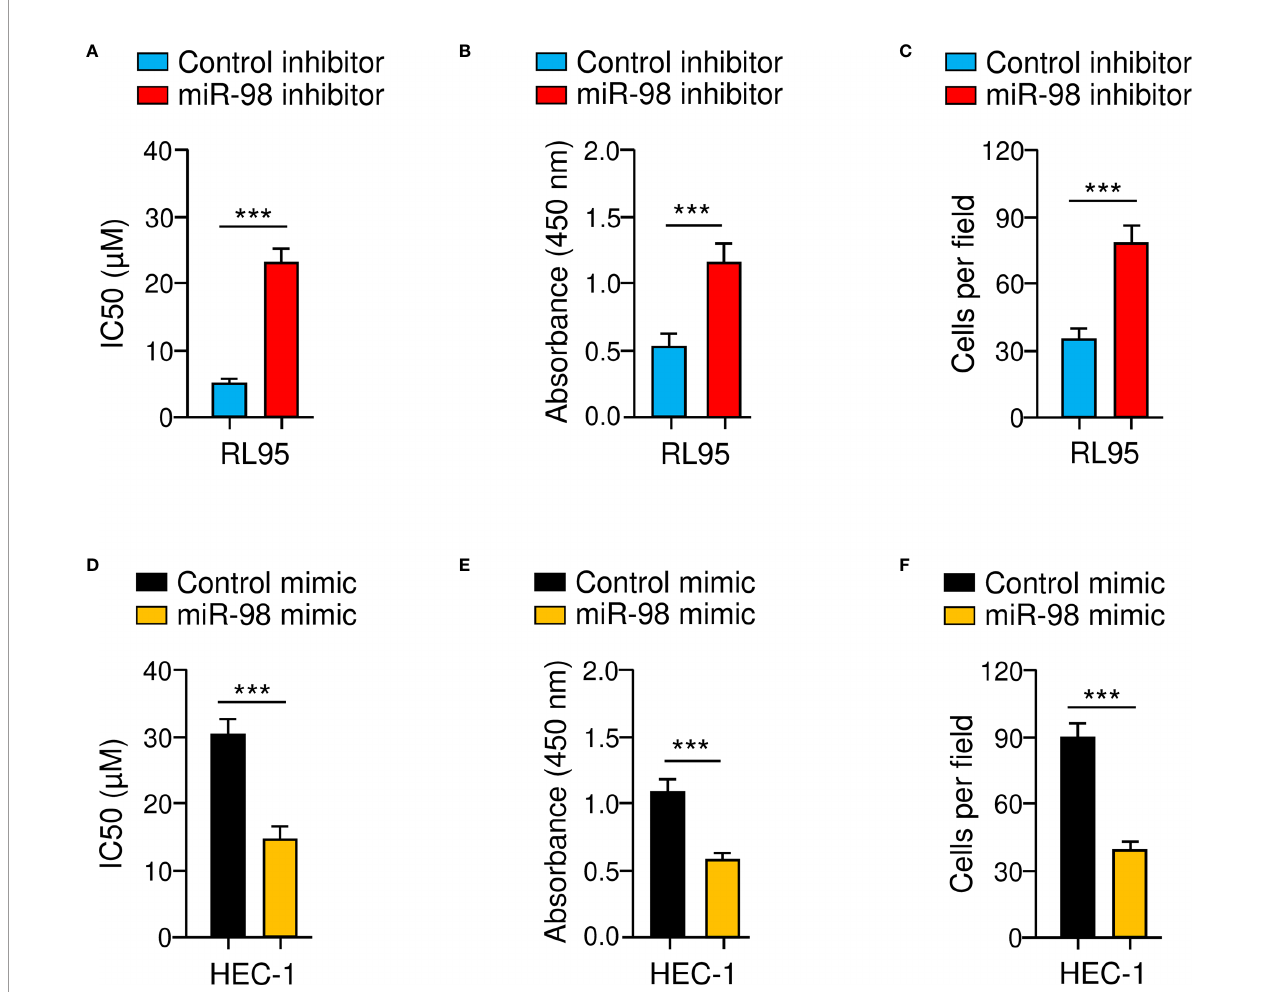
FIGURE 7 | Knockdown of MiR-98 Induces Paclitaxel Resistance and Aggressive Properties of EC cells. (A – C) Drug sensitivity assays (A) , cell proliferation assays (B) , and cell invasion assays (C) were carried out in RL95 cells transfected with miR-98 inhibitor or control inhibitor. (D – F) Drug sensitivity assays (D) , cell proliferation assays (E) , and cell invasion assays (F) were performed in HEC-1 cells transfected with miR-98 mimic or control mimic. *** P <